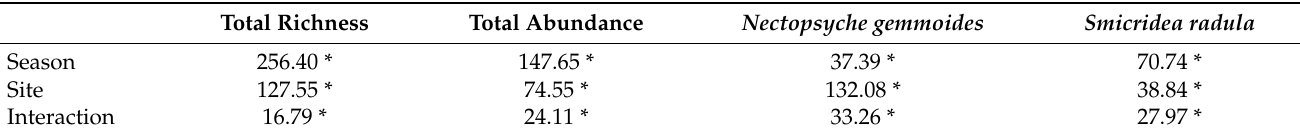
Table 8. Values of F for two-way ANOVA test to evaluate season, site, and interaction (season X site) effects on total richness, total abundance of Trichoptera, and on the two dominant species, in the Sierra de Ju á rez, Oaxaca, Mexico. * p < 0.001; gl season = 1, gl site = 4, gl interaction = 4.